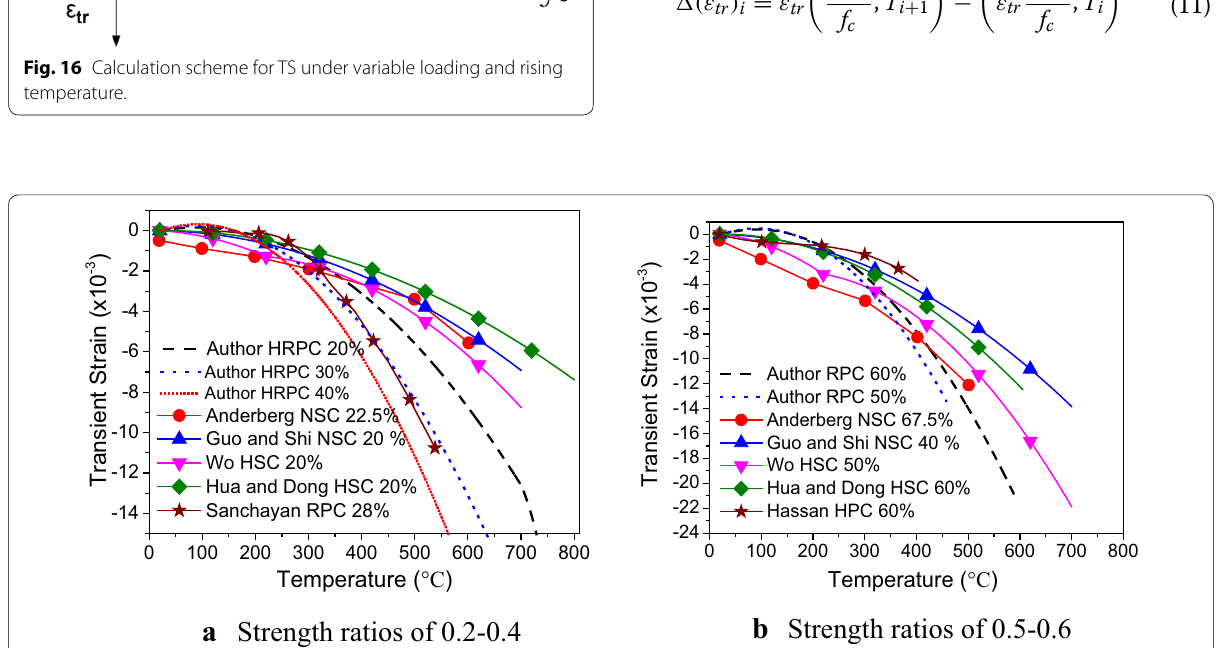
Fig. 17 Comparison of TS of HRPC with NSC, HSC and